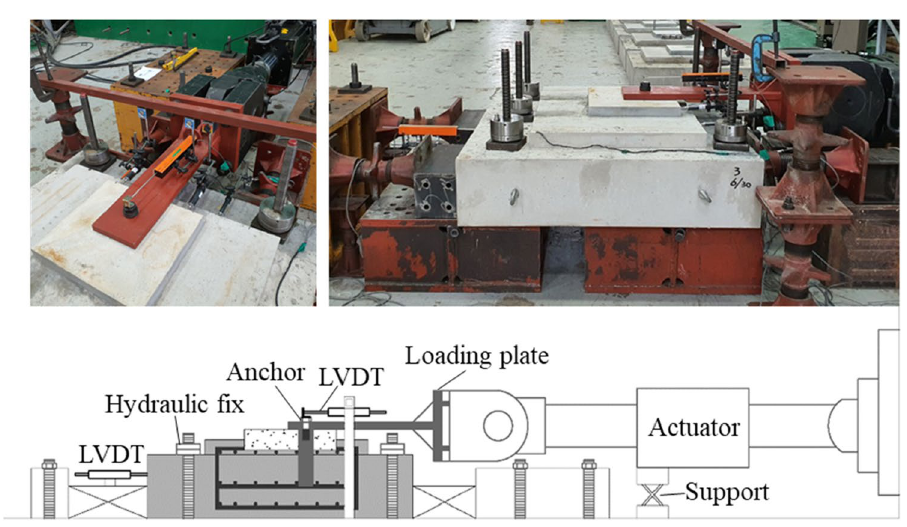
Figure 6. Test setup for monotonic shear